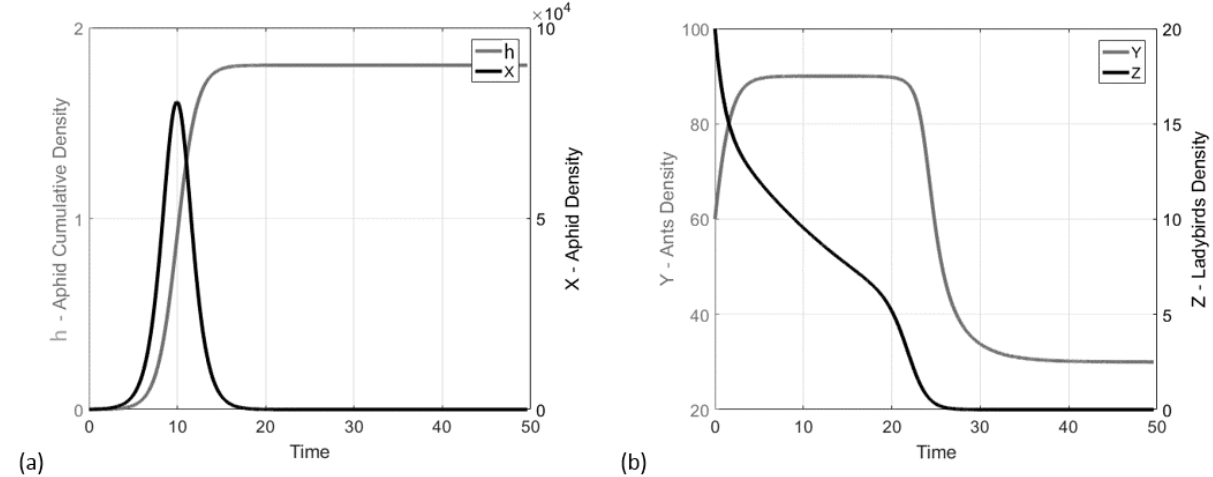
Figure 3. Trajectories of h , x , y , z obtained by iteration of (20), by assuming the same parameters values of Figure 2: (a) h is represented by the gray line and x by the black one; (b) y is represented by the gray line and z by the black one.